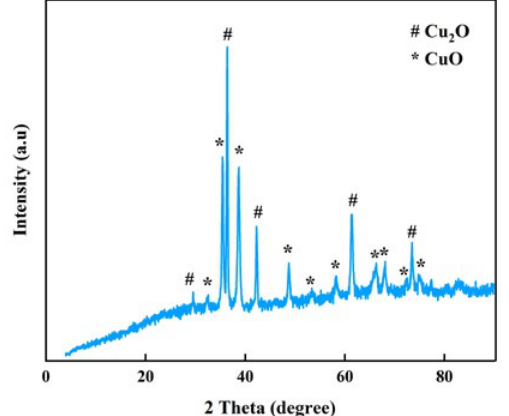
Fig. 2. Powder X-ray diffraction patterns for [Cu(BDC)(bipy)] ) analogs; (a) the original form, (b) as synthesized. (BDCH 2